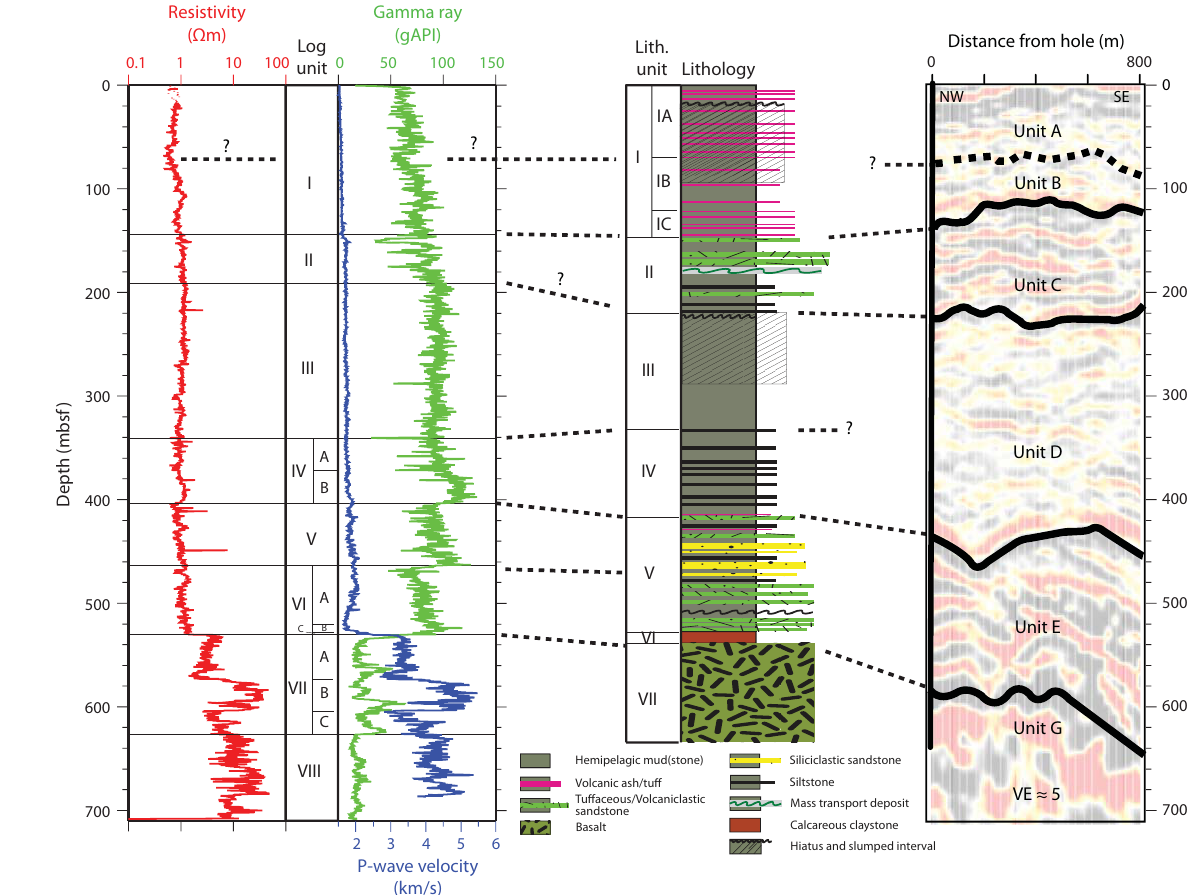
Figure 11. Core-log-seismic integration at Site C0012: LWD data from Hole C0012H with unit boundaries, composite lithologic column (holes C0012A–C0012G; Expedition 333 Scientists, 2012b), and seismic data from In-line 95 (IFREE 3-D PSDM volume; Park et al., 2008) showing the interpretation of Expedition 322 Scientists (2010). Black dashed lines = correlations (“?” = tentative) between unit boundaries identified for each data set. VE = vertical